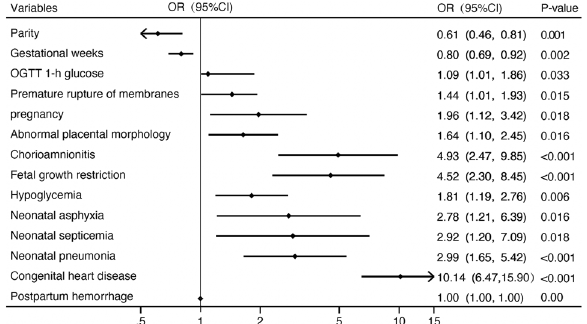
Figure 2. Maternal factors and neonatal outcomes associated with neonatal